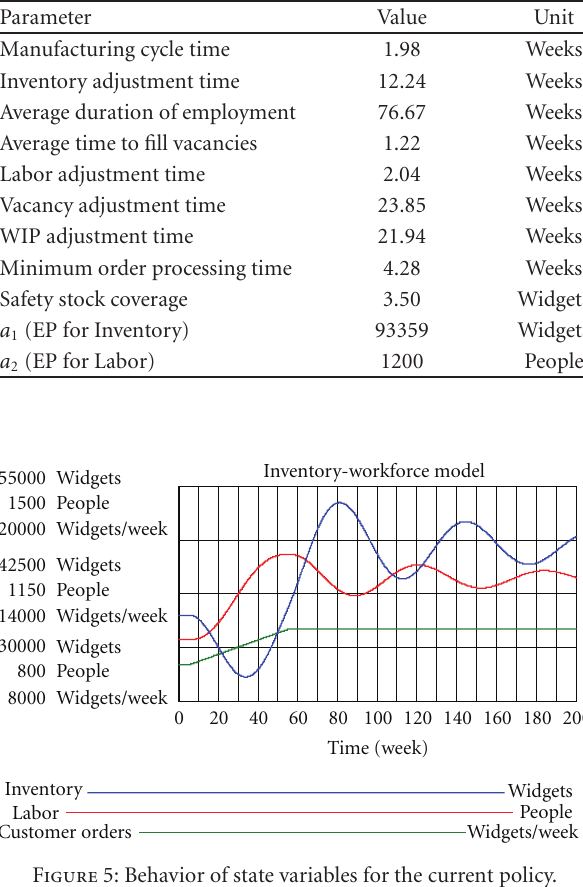
approach production more closely to the desired production rates. As a result, the EP of the inventory variable has increased from 40000 units to 93359 units. The EP for the labor variable remains not far from its original value of 1000 people. Stabilization of both variables has been achieved in approximately 80 weeks.